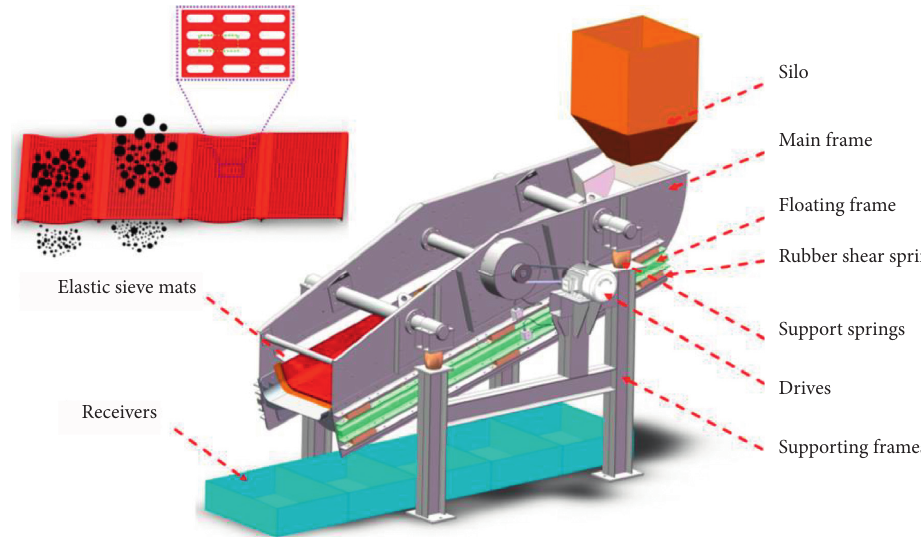
Figure 2: Schematic diagram of VFFS and the screening system.